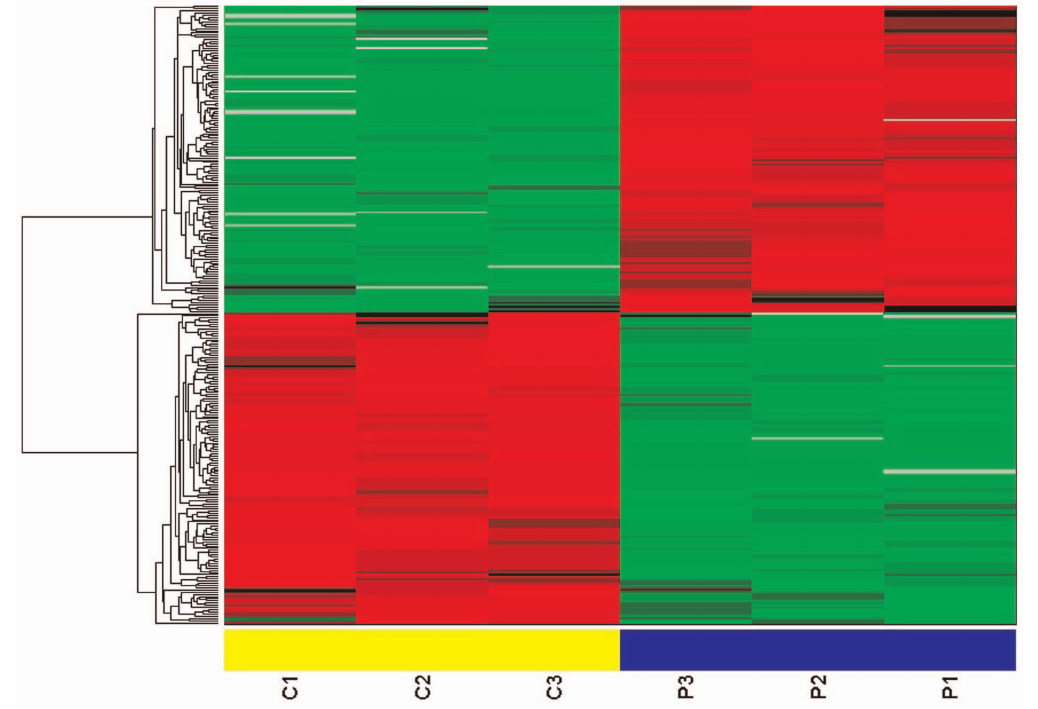
Figure 1. Hierarchical cluster analysis of the proteins expressed with statistically significant differences (P , 0.05, and fold change . 1.5 or , 0.667) in cancer tissue and paracancerous normal tissue from patients with laryngeal carcinoma. Three independent experiments were performed in cancer tissue (C1, C2, C3) and paracancerous normal tissue (P1, P2, P3).